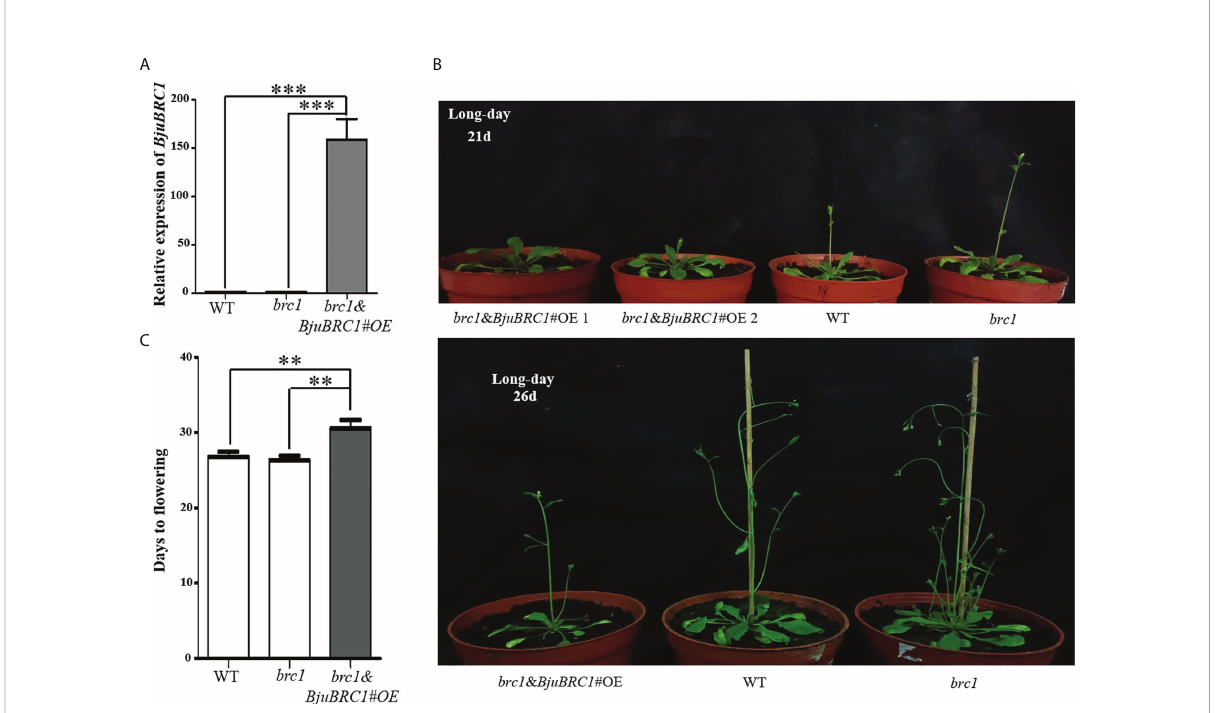
FIGURE 3 Flowering time comparison of distinct Arabidopsis lines. (A) The relative expression level of BjuBRC1 -1 in transgenic Arabidopsis ( brc1 mutant background), WT, and brc1 Arabidopsis . “ *** ” indicates signi fi cant difference, p < 0.001, by Student ’ s t-test. (B) Overexpression of BjuBRC1 -1 delayed fl owering. (C) Days to fl owering of the WT, brc1 , and the transgenic Arabidopsis . Error bars represent SE. “ ** ” indicates signi fi cant difference, p < 0.01, by Student ’ s